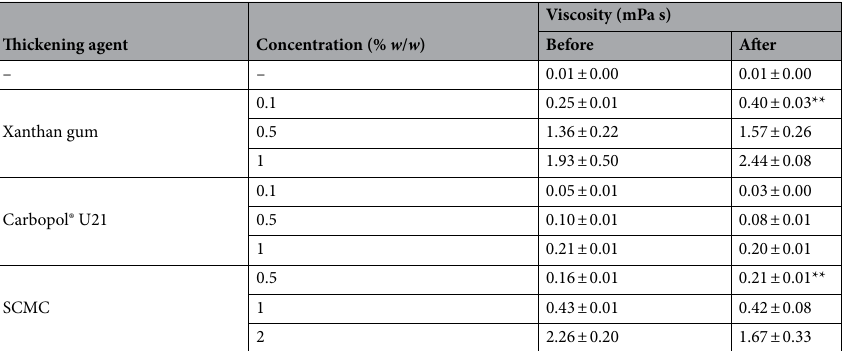
Table 3. Viscosity of lamellar liquid crystals (LLCs) using various thickening agent types and amounts before and after eight heating–cooling cycles to test stability. NOTE: LC = C20–22 alkyl phosphate and C20–22 fatty alcohol (Runemul TM Favor LC); LCM = sorbitan stearate and sucrose cocoate (Liquid Crystal Cream Maker). Asterisks (**) denote a significant difference in viscosity before and after the heating–cooling stability test ( p <